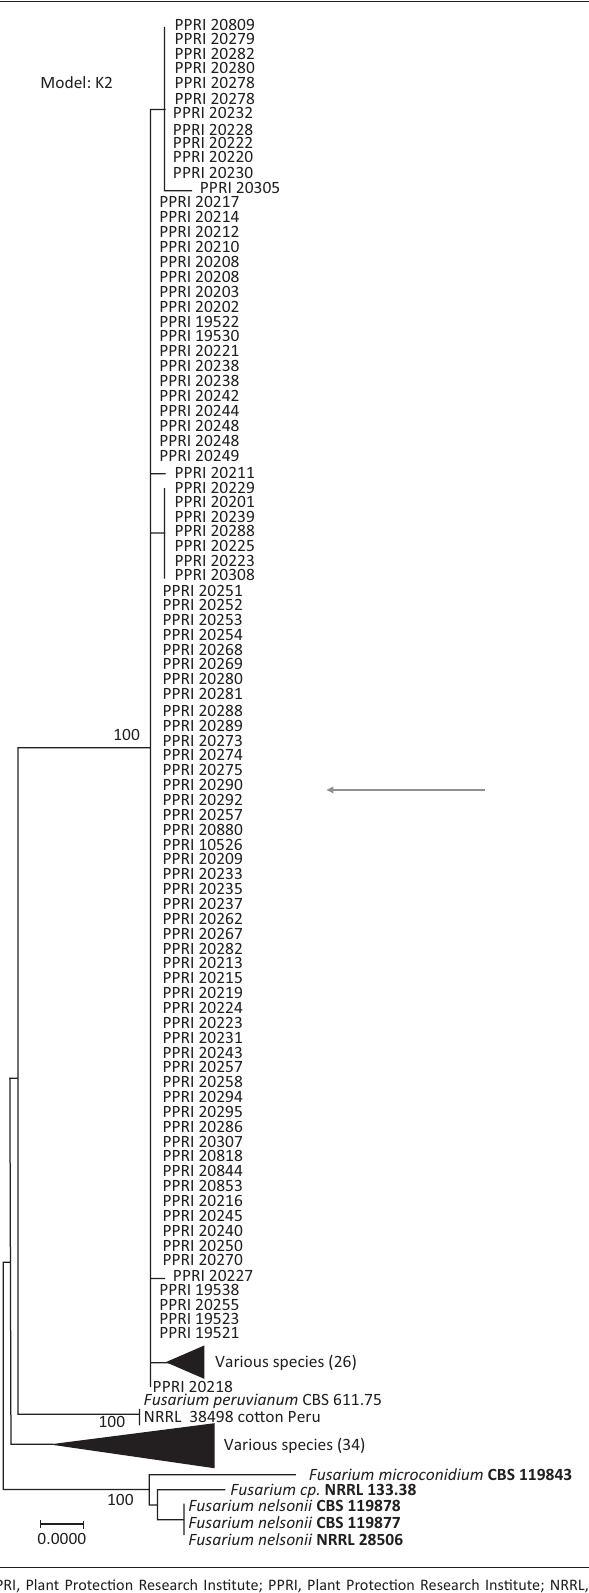
FIGURE 3: Unrooted maximum likelihood phylogram of all currently sequenced Fusarium species in the Fusarium chlamydosporum species complex based on translation elongation factor 1-a gene sequences. Bootstrap support values higher than 80 % are shown on the branches. The evolutionary model applied to the analysis is indicated on the figure. Isolates from this study are indicated with PPRI numbers.